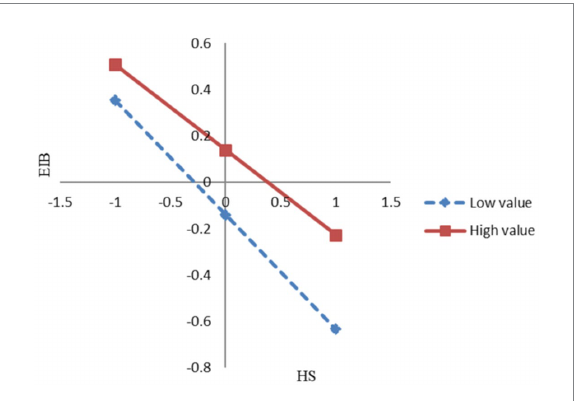
FIGURE 2 The moderating effect of proactive personality (PP).